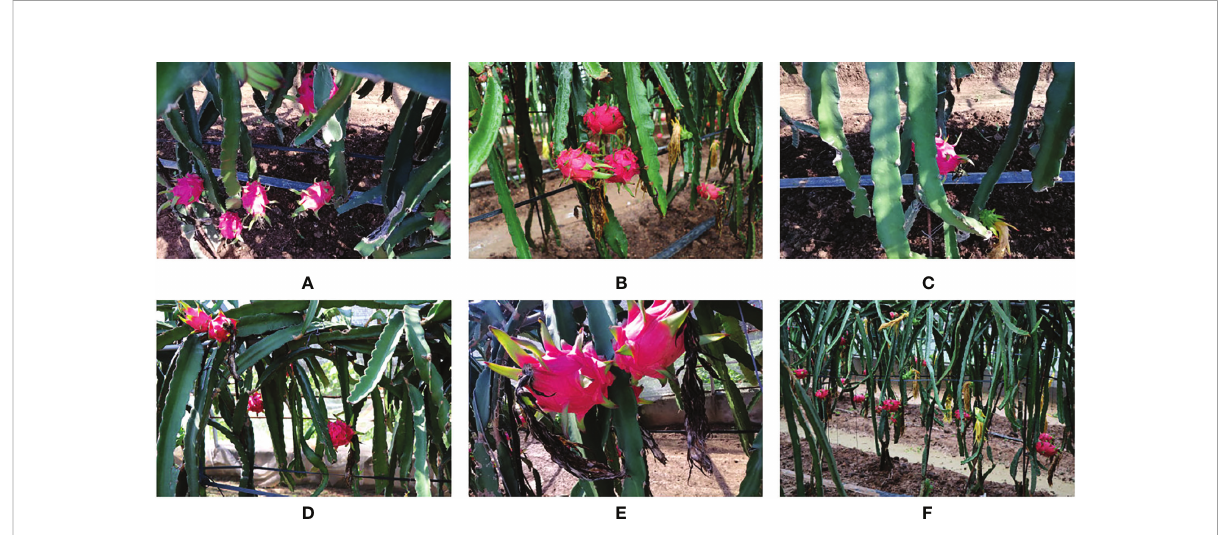
FIGURE 1 Some images of pitayas in greenhouse environment: (A) Mature pitayas in sunny days; (B) Mature pitayas in rainy days; (C) Occlusion of pitayas; (D) Adhesive pitayas; (E) Short distance pitayas; (F) Long distance